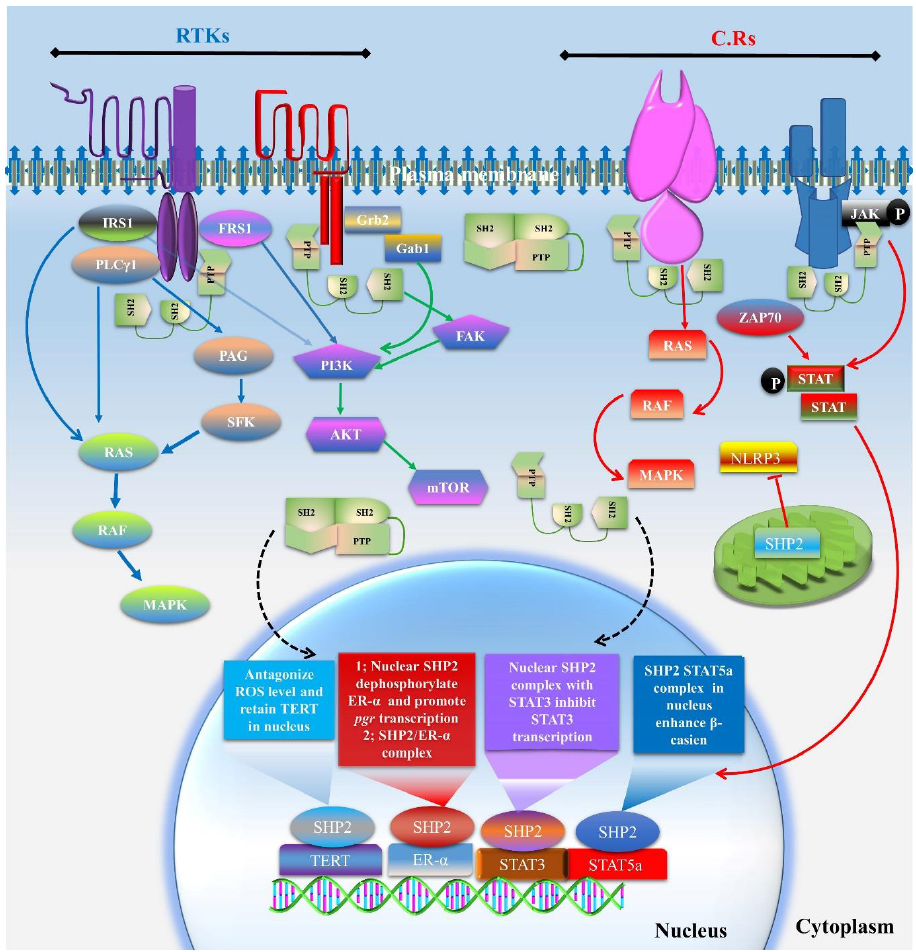
Figure 2. SHP2 dependent growth factors and cytokines receptors (CRs) signal transduction and interaction with nuclear factors. SHP2 is essential for regulating several key ligand-dependent pathways and also participate in the activities of several transcriptional factors. Insulin receptor substrate (IRS) dependent RAS / RAF / MAPK has been identified, and SHP2 was found to play a significant role in this signaling. Phospholipase C gamma (PCL γ ) also activates RAS / MAPK via PAG and SFK, which also need SHP2 for this signal transduction. Far1-related sequence (FRS1) has been activated by FGF ligand via FGF receptor, and FRS1 dephosphorylation by SHP2 is a known mechanism for FGF signaling. Growth factor receptor-bound protein 2 (Grb2) and Grb-associated-binding protein (Gab1) were found to be activated by EGF and a few other ligands, and SHP2 shows its association with them for the activation of MAPK and AKT signaling. CRs adaptor proteins like Janus kinase (JAK) and Zeta-chain-associated protein kinase 70 (ZAP70) also need SHP2 for MAPK and STAT signaling. Other than these signaling SHP2, it has also been identified in mitochondria, resisting NLRP3 localization and mitochondrial toxicity. Nuclear localized SHP2 active or auto inhibition state is as yet unknown, and also during complex formation with other transcription factors, but several studies have identified the interaction of SHP2 with TERT, ER- α , STAT3, and